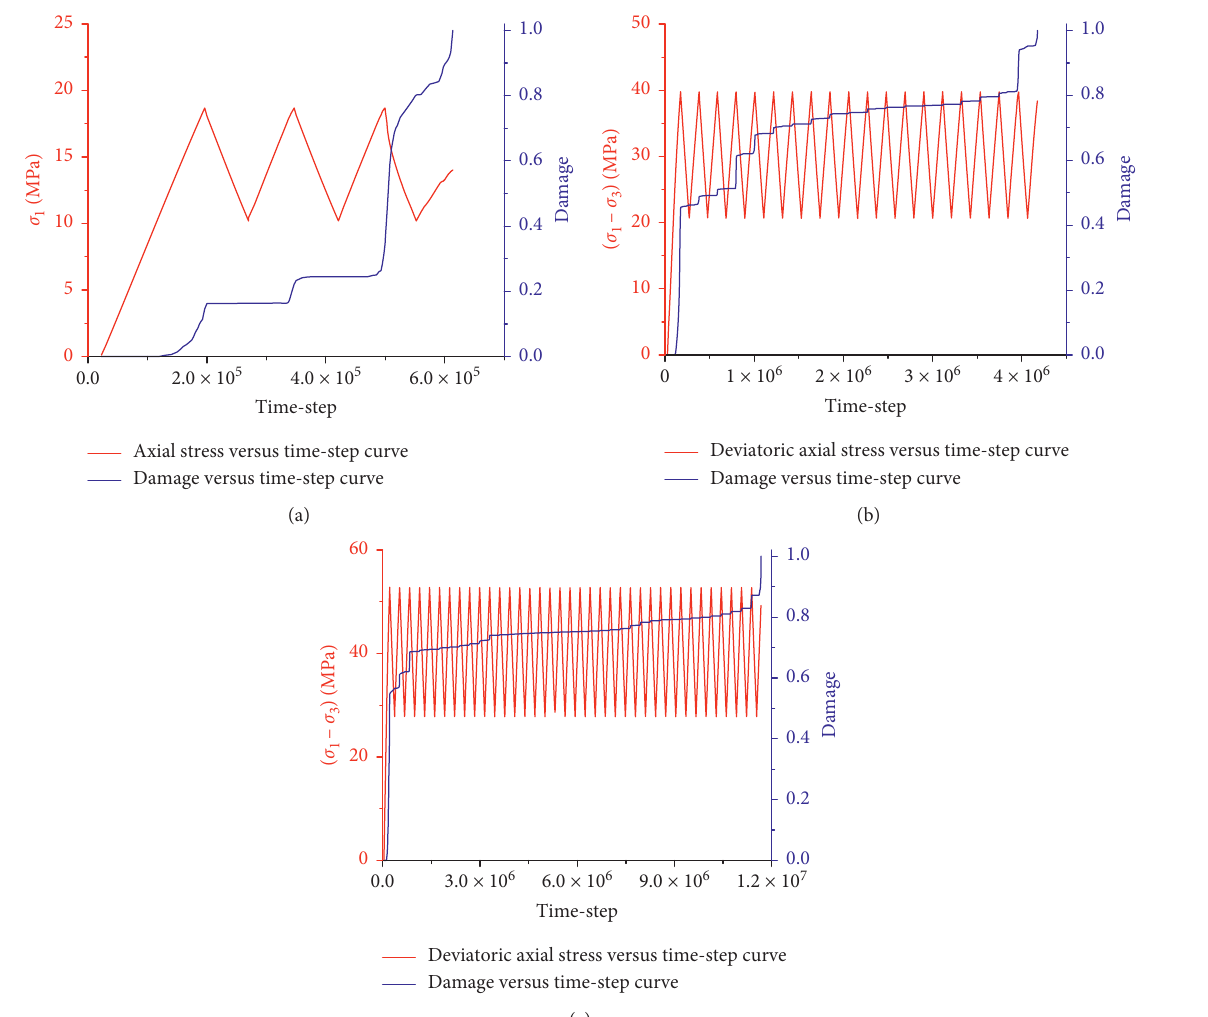
Figure 16: The damage evolution curves of coal specimen subjected to cyclic loading under the different confining pressures: (a) 0MPa, (b) 5MPa, and (c) 10